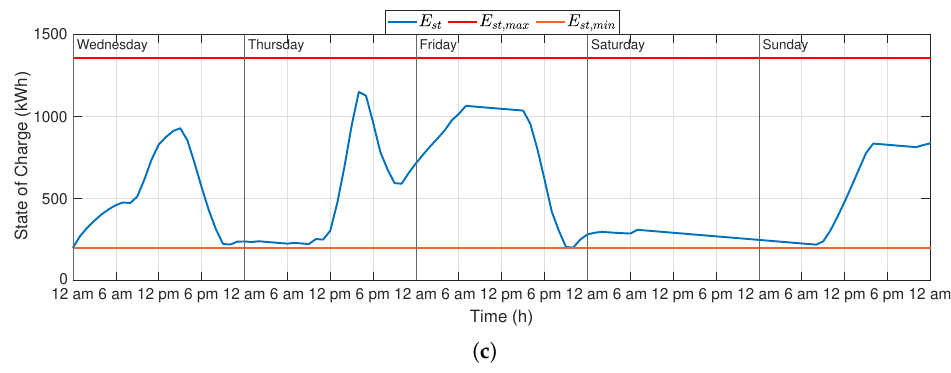
Figure 8. MPC results with Australian prices in a simulation of five days: ( a ) Cost and revenue of energy; ( b ) Power Profiles; ( c ) State of